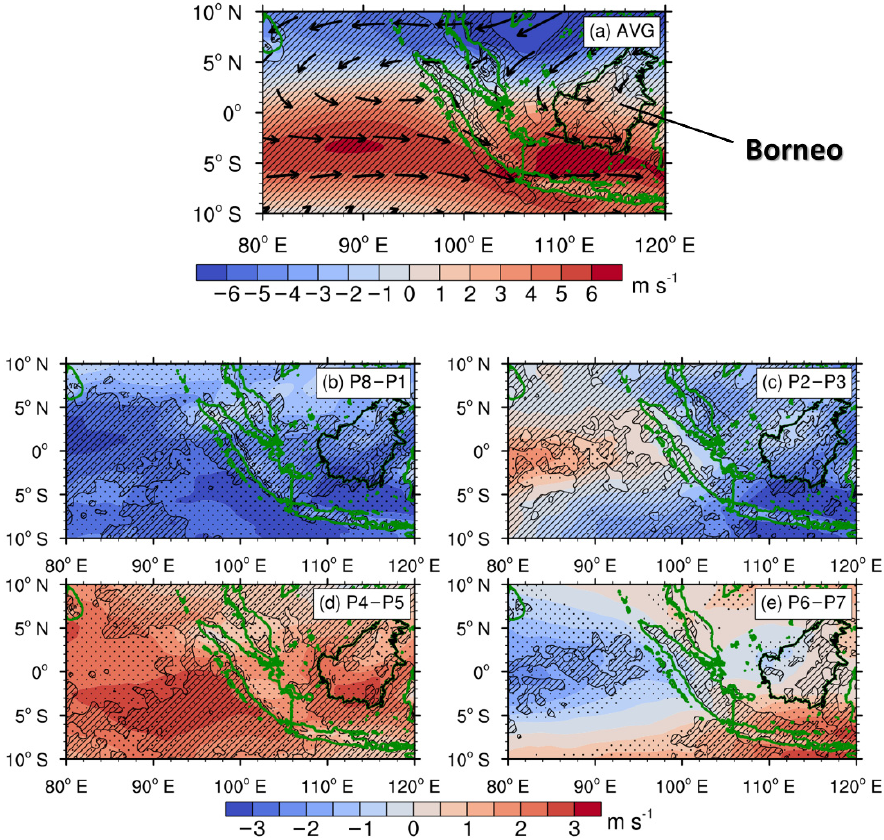
Figure 5. The horizontal distributions of zonal wind (shaded, m s − 1 ) and vertical motions (contour, 0.5 cm s − 1 ) at 850 hPa ( a ) averaged in DJF 2011–2020 as well as its anomaly in ( b ) P8–P1, ( c ) P2–P3, ( d ) P4–P5 and ( e ) P6–P7. The black outline marks the island of Borneo. The diagonal lines indicate the positive (upward) averages or phase anomalies for vertical motions. The black dots indicate the 95% confidence according to the Student’s t -test.